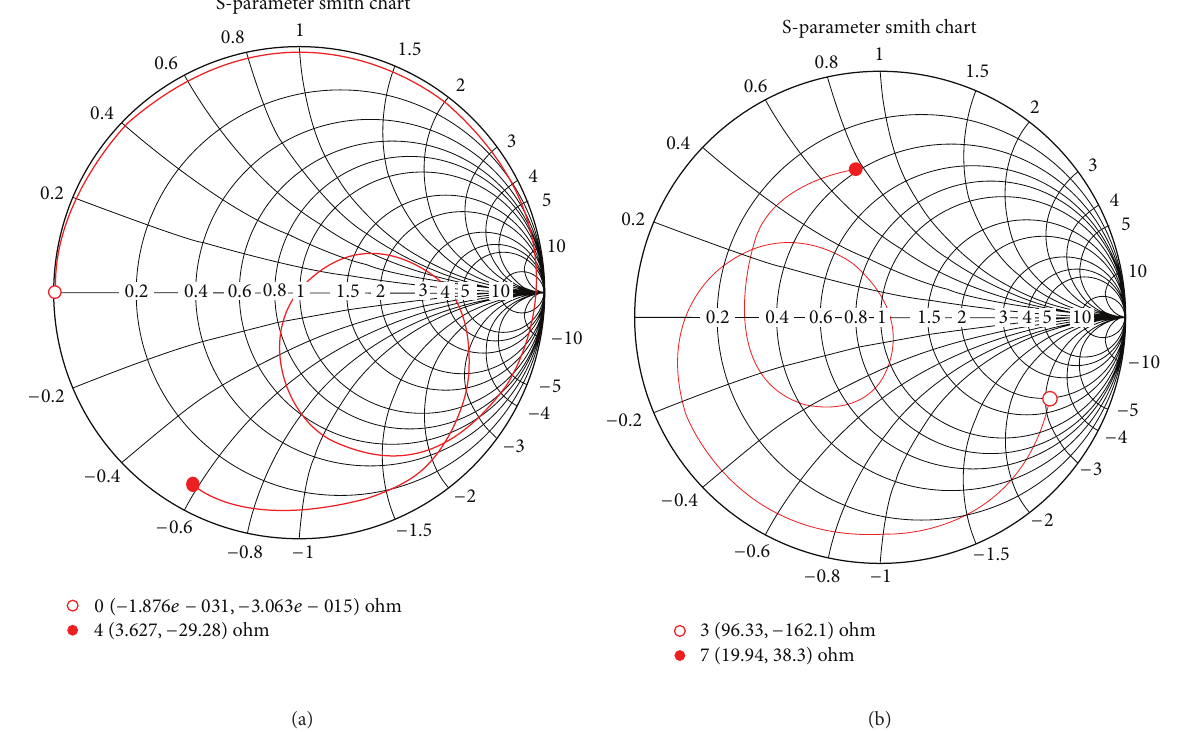
Figure 3: Smith chart of the complex reflection coefficient of the dual-band K2 PIFA in the overlapping frequency ranges DC-4 GHz and 3–7 GHz.